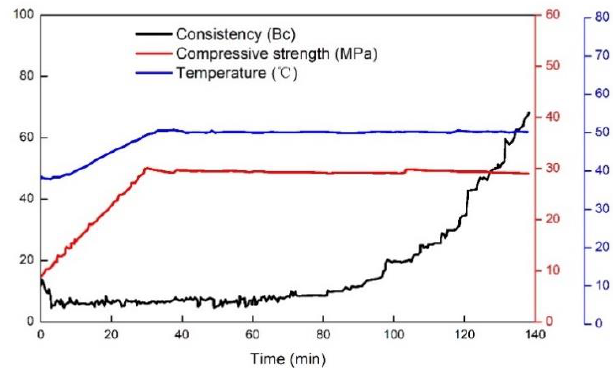
( b ) Figure 16. Micrograph of compressive strength of SCGPCS. ( a ) XRD diagram. ( b ) SEM.